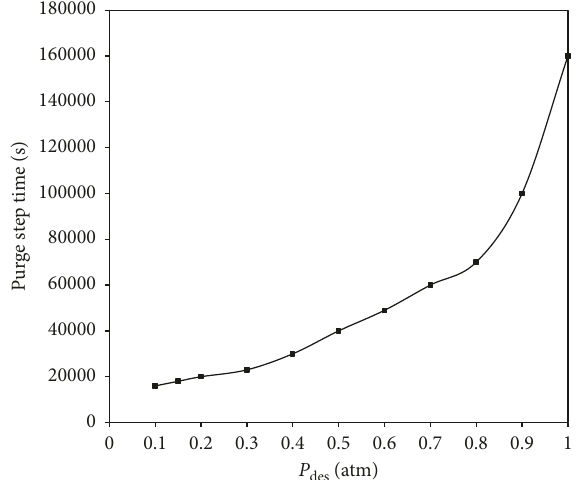
Figure 15: Variation of purge step time with vacuum pressure for mixtures dichloromethane/acetone vapor at 3000ppm/1500 ppm exposure concentration.